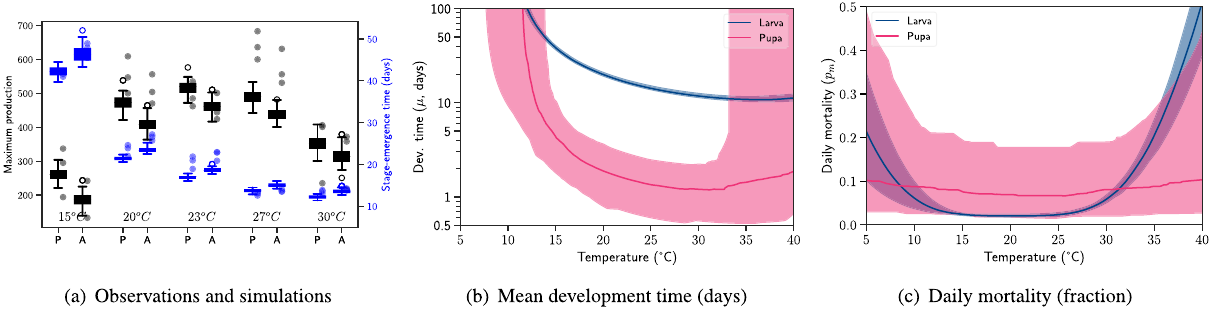
Figure 3. Inverse modelling of Cx. quinquefasciatus environmental dependency. The comparison of observed and simulated maximum pupa (P) and adult (A) production and the corresponding stage-emergence times is given in ( a ). Observations are represented with dots and simulations with box plots. The environmental dependency of larva and pupa development time ( b ) and mortality ( c ), derived by the posterior mode sample (cid:31) q , is shown in ( b , c ). Solid lines represent the median and shaded areas represent the 90%